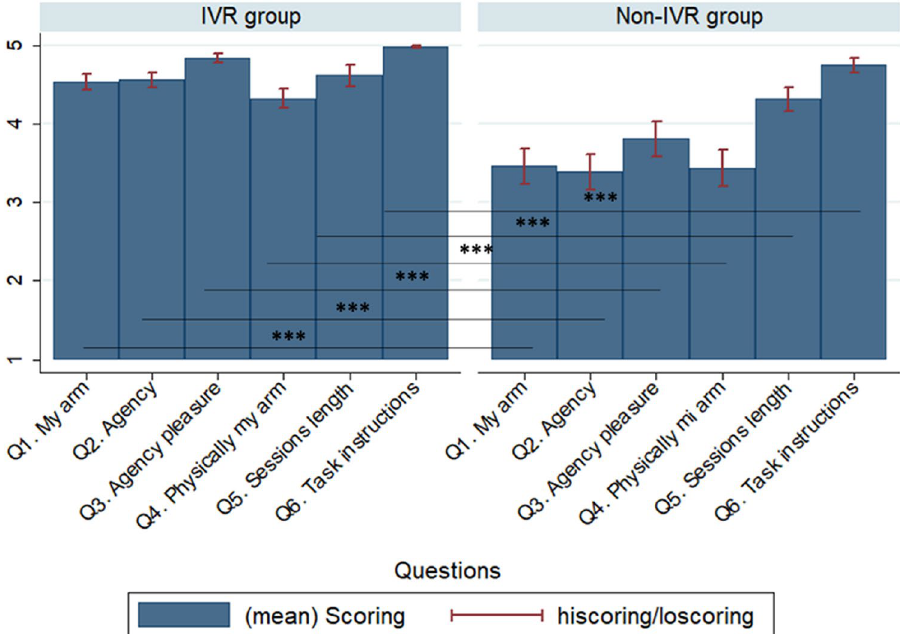
Figure 4. Virtual reality questionnaire differences between immersive VR and non-immersive VR groups and the relationship with functional ability recovery. Virtual reality questionnaire score differences between immersive VR and non-immersive VR groups. There were significant differences between groups for all questions of the virtual reality questionnaire, showing higher scores in questions related to the sense of ownership of the virtual body and the sense of agency by controlling the virtual arm movement. The graph also presents higher scores with respect to the appropriateness of the session duration, and clarity of the task instructions during the training sessions. Hiscoring = high scoring)/loscoring = low scoring.